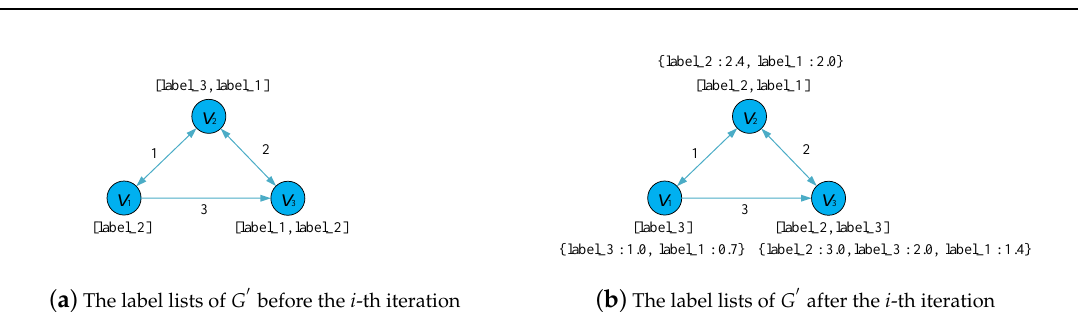
Figure 4. An example of an iteration in the multi-label propagation algorithm with k = 2, r = 1.0 and α = 0.3. Texts next to nodes represent the label list (enclosed in brackets) and the label dictionary (enclosed in braces) of the